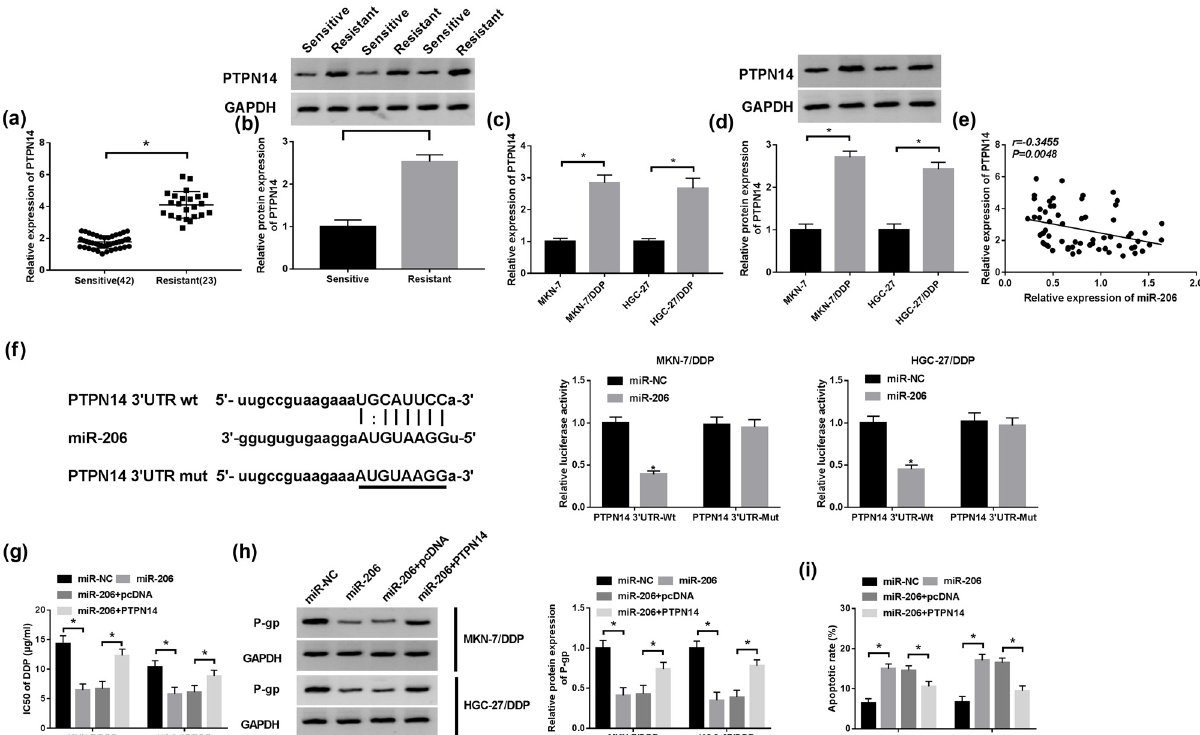
Figure 6: miR - 206 inhibits cisplatin resistance of resistant GC cells via targeting PTPN14. ( a and b ) PTPN14 expression was measured in sensitive ( n = 42 ) and resistant ( n = 23 ) GC tissues via RT - qPCR and Western blot. ( c and d ) PTPN14 expression was detected in sensitive and resistant GC cells by RT - qPCR and Western blot. ( e ) The linear correlation between levels of PTPN14 and miR - 206 in GC tissues was analyzed. ( f ) The binding sites of miR - 206 and PTPN14 were searched via starBase, and luciferase activity was detected in MKN - 7/DDP and HGC - 27/ DDP cells co - transfected with miR - NC or miR - 206 mimic and PTPN14 3 ′ UTR - Wt or PTPN14 3 ′ UTR - Mut. IC 50 of cisplatin ( g ) , P - gp protein level ( h ) and apoptotic rate ( i ) were measured in MKN - 7/DDP and HGC - 27/DDP cells transfected with miR - NC, miR - 206 mimic, miR - 206 mimic + pcDNA or PTPN14 overexpression vector via MTT, Western blot and fl ow cytometry, respectively. * P <